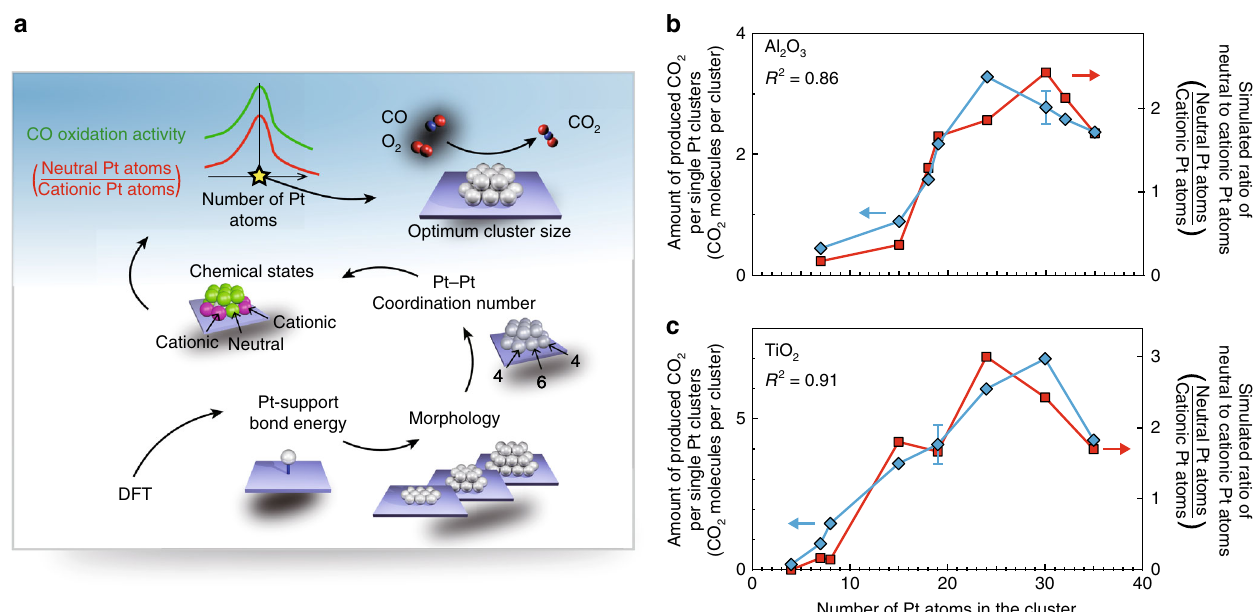
Fig. 5 Prediction of the optimum Pt cluster size for maximum CO oxidation activity. a Schematic diagram illustrating the protocol used for optimum Pt cluster size prediction. The process starts with a theoretical calculation of the binding energy for a Pt monomer on the support material. b , c Comparison of the atomic ratios of neutral to cationic Pt atoms (red squares) with the amounts of CO 2 produced for Pt n /Al 2 O 3 ( b ) and Pt n /TiO 2 ( c ) (blue diamonds). The error bars are standard deviation. Source data are provided as a Source Data fi